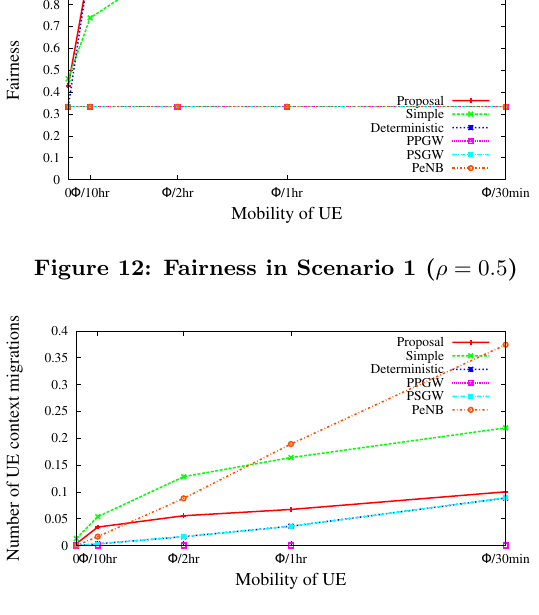
Figure 10: Number of UE context migrations in